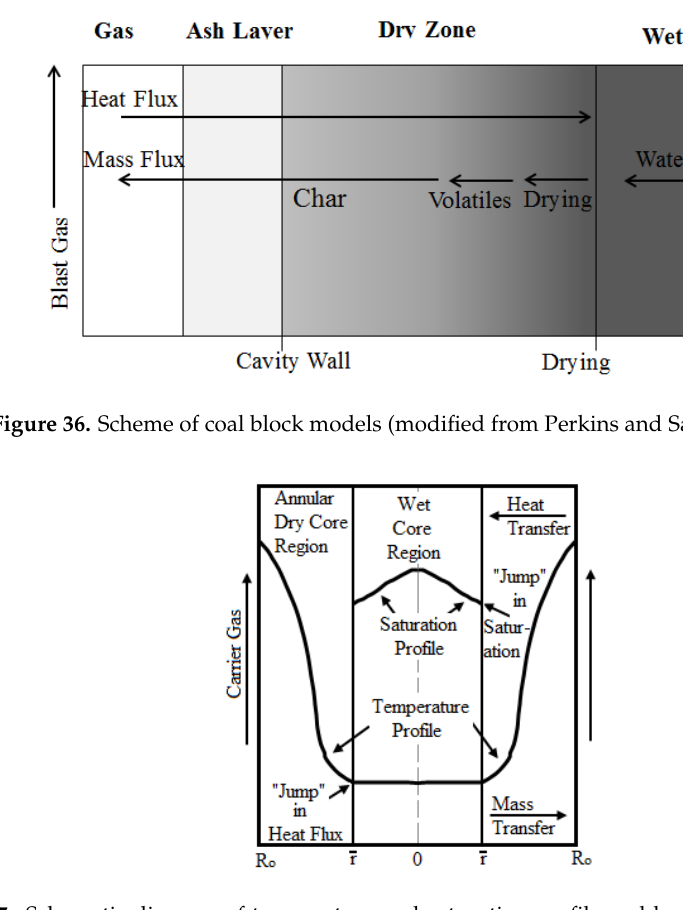
Figure 37. Schematic diagram of temperature and saturation profile and heat and mass transfer in coal block (redrawn from Tsang [74]).